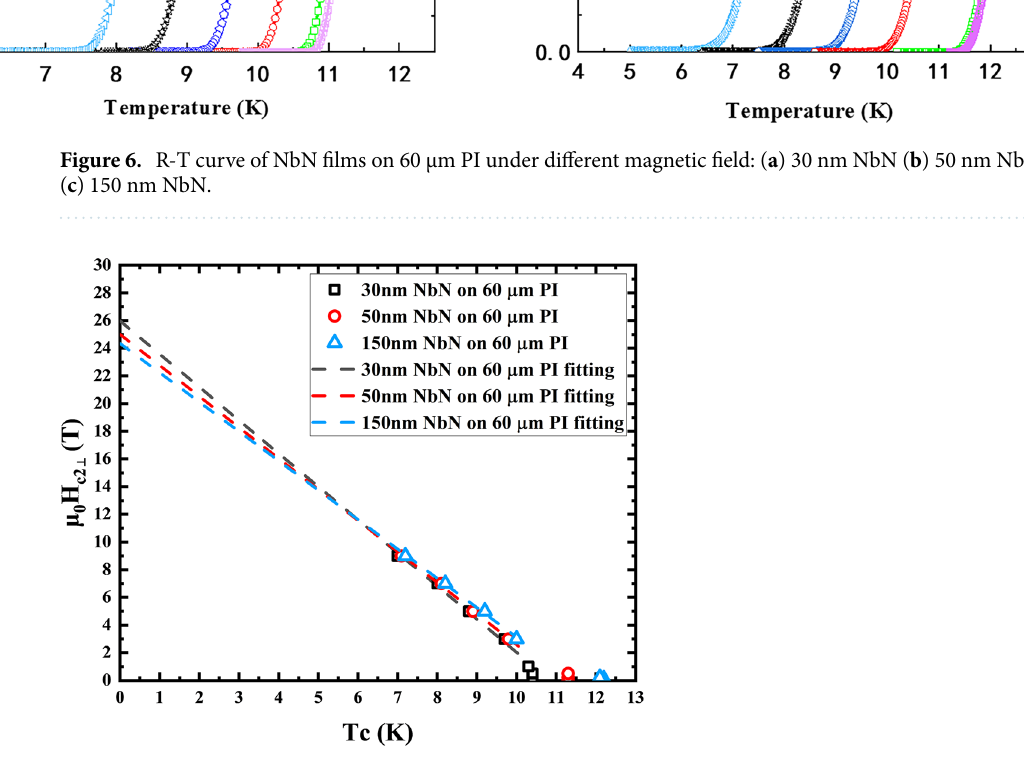
Figure 7. Superconducting upper critical magnetic field perpendicular to the NbN films on 60 μm PI measured and fitted with varied